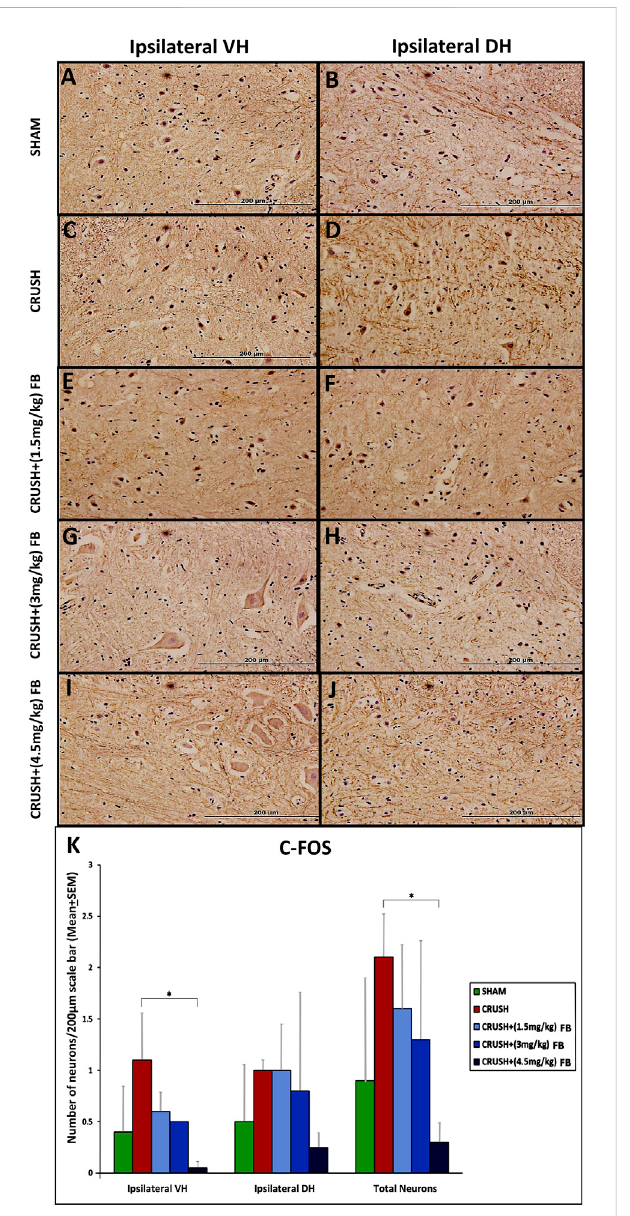
FIGURE 8 (A – J) : c-Fos immunohistochemistry in the ipsilateral lumbar spinal cord regions after sciatic nerve crush injury. Weak immunoreactivity was observed in the nuclei of the spinal neurons of the CRUSH group (Magni fi cation ×40). (K) After sciatic nerve crush injury, the number ofc-Fospositiveneuronsinthespinalcord ’ sipsilateralventralanddorsal horns. The number of c-Fos positive neurons markedly decreased with FB treatment in the spinal cord ’ s anterior and dorsal horns. Data are expressed as mean ± SEM. * p < 0.05, ** p < 0.01, and *** p < 0.001.